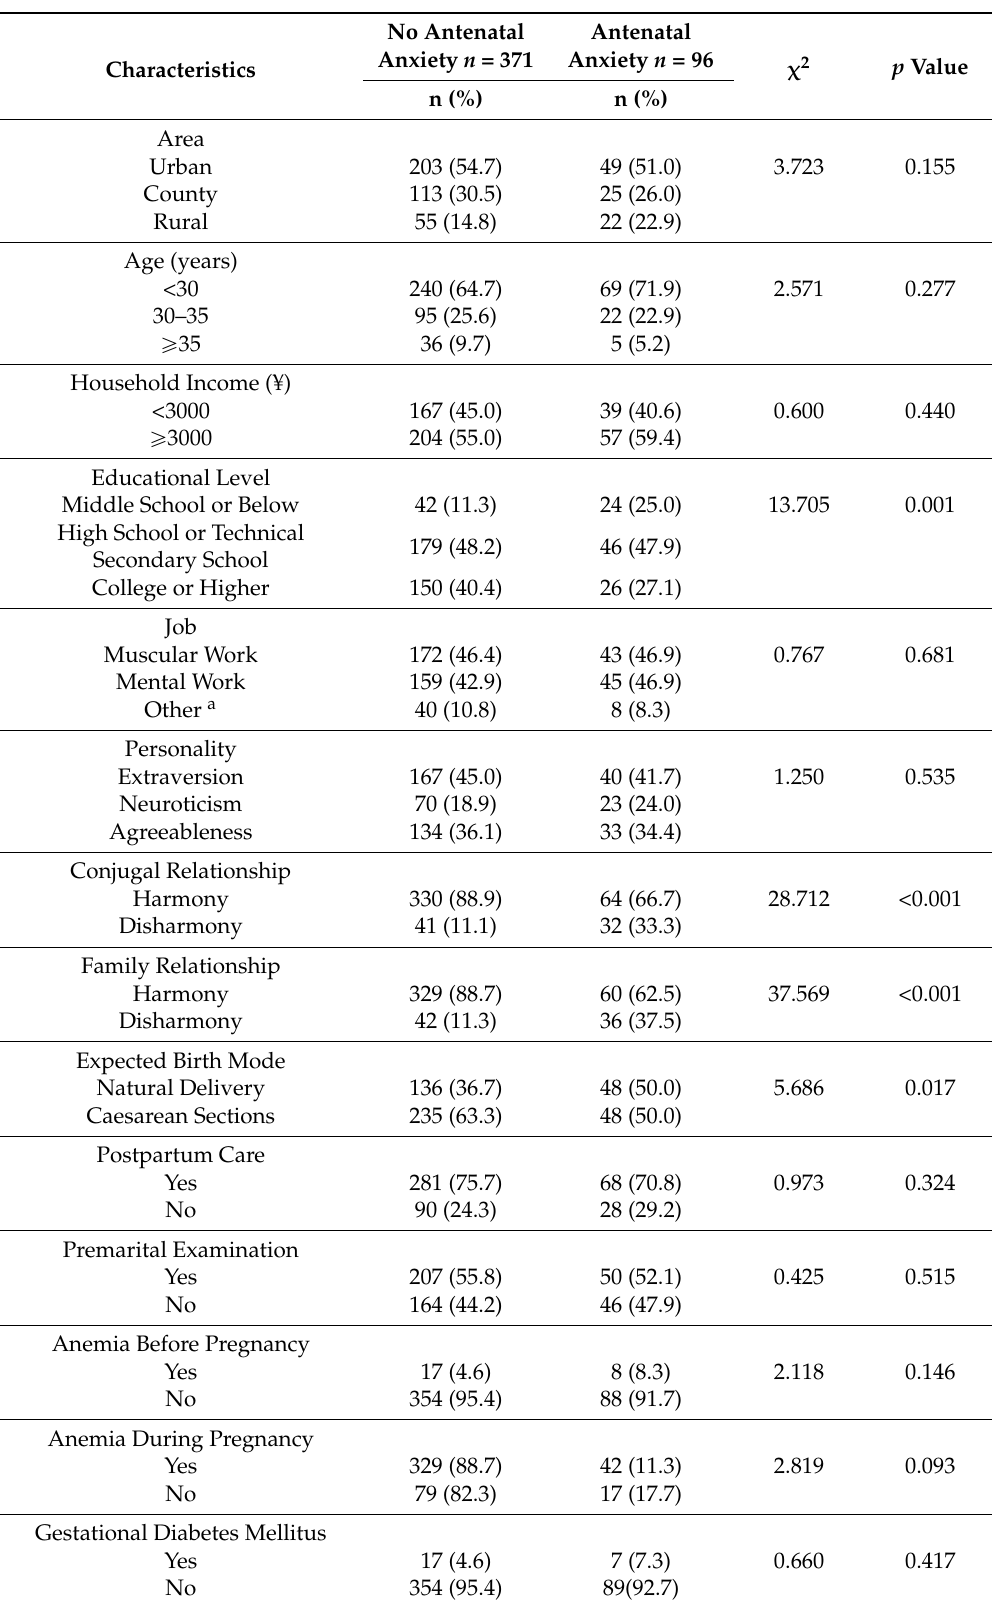
Table 1. Socio-demographic characteristics and health states of the total participants ( n = 467).